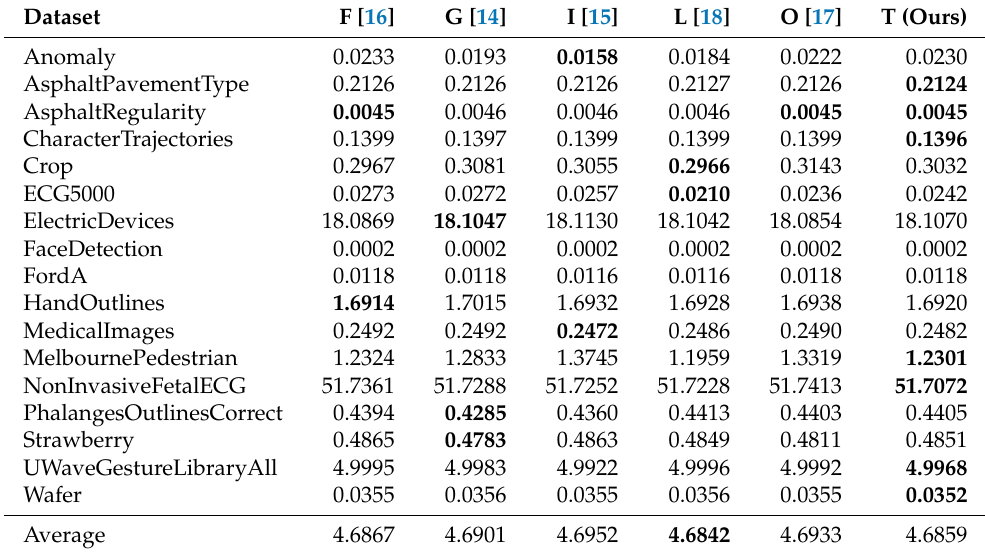
Table 4. Infidelity. Lower values correspond to better performance. The Method names are shortened by taking only the initial character (FeatureAblation, Guided-Backpropagation, IntegratedGradients, LIME, Occlusion, TimeREISE). There are only insignificant differences between the methods. Lime shows the best performance. TimeREISE takes the second place. Best results are highlighted in bold.